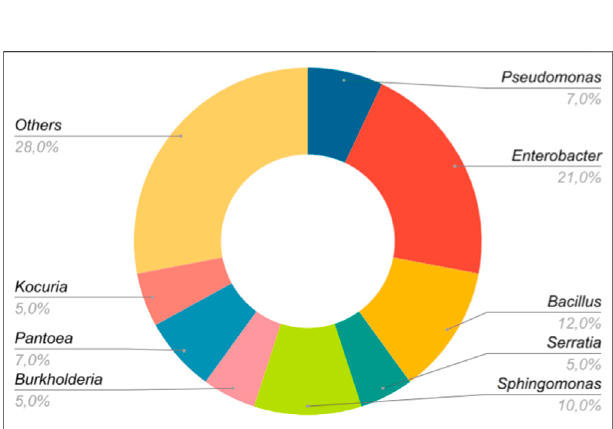
FIGURE 4 | Most representative bacterial genera used in the experiments. The genera used in only one study ( n (cid:1) 1) were grouped in the category “ Others.